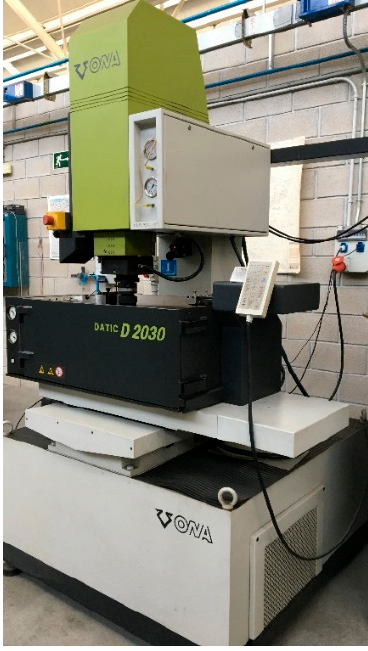
Figure 3. Electrical discharge machining (EDM) machine ONA Datic D-2030-S.